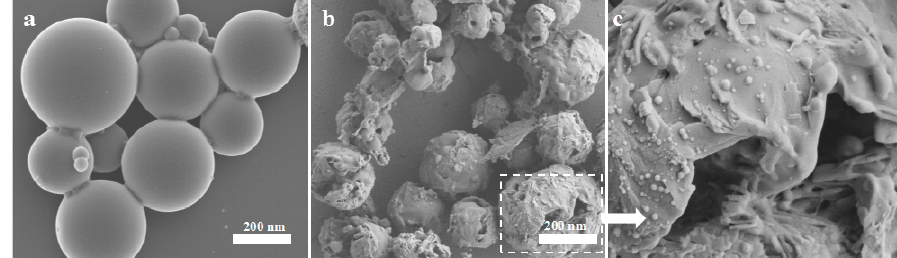
Figure 8. SEM micrographs of PLA nanoparticles ( a ) before and ( b , c ) after 10 days of pesticide